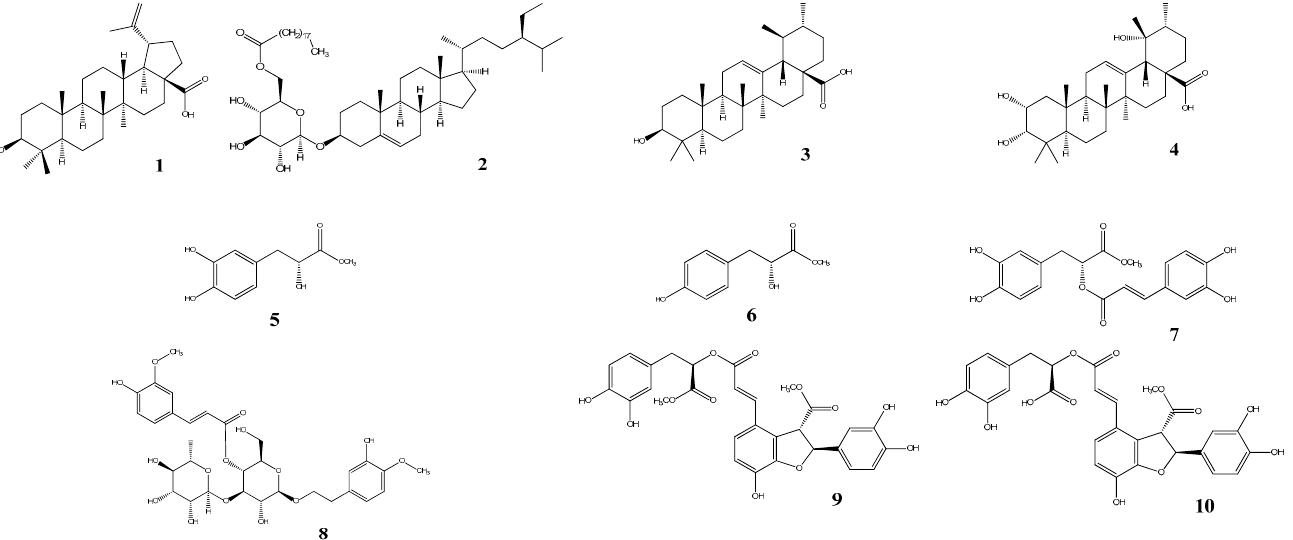
Figure 1. Structures of isolated compounds 1 – 10 from L. lucidus .